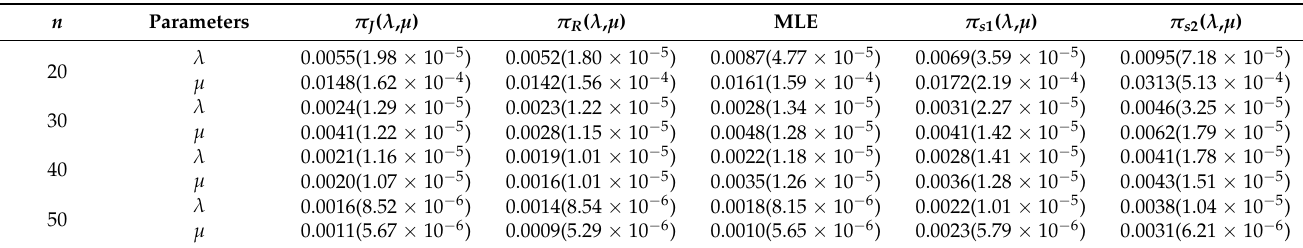
Table 2. ABs and MSEs (within bracket) of parameters based on MLE, subjective Bayesian and objective Bayeisan estimations in case I.